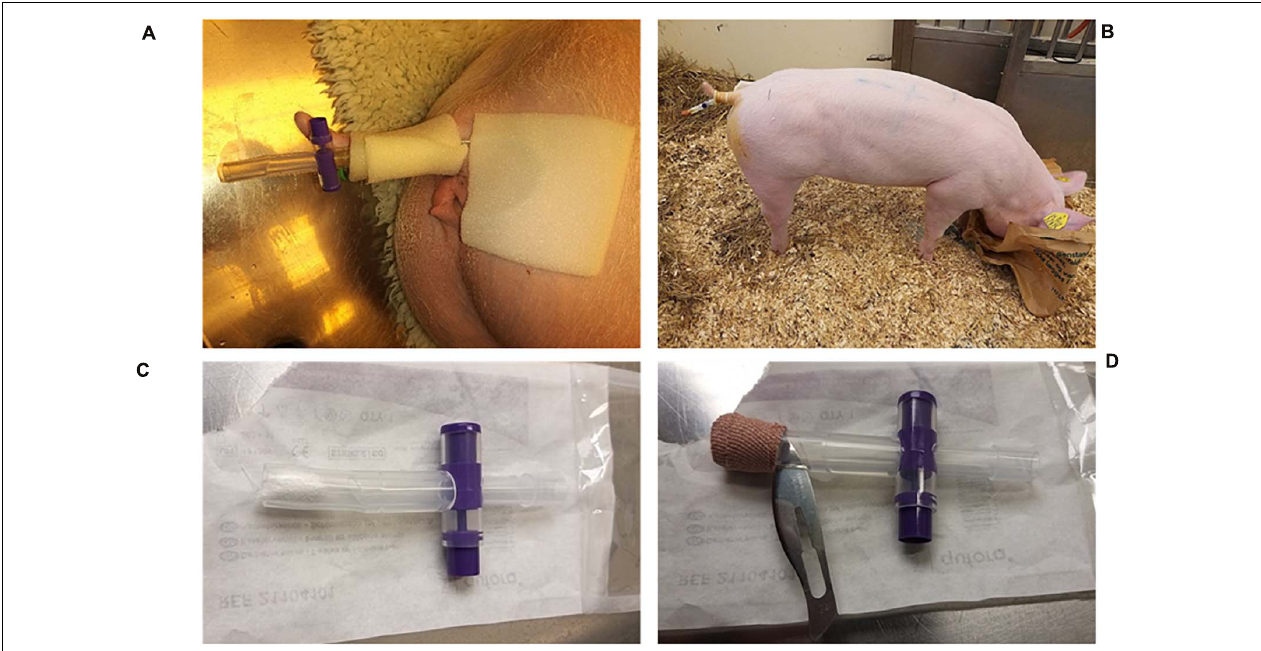
FIGURE 2 | Catheter fixation. (A) External fixation of the catheter. (B) The catheters were easily accessible, and due to proper training prior to the experiment, urine samples could be collected without the need for sedation. (C) To limit contamination of the catheters from the environment, the catheter end was always covered with a replaceable catheter valve that was either closed when accumulating urine for sampling (A) or open and sealed with gauze swaps (C) and secured with tape (D) so that urine could slowly drip through. (D) A secondary non-return valve was made by cutting a thin slit in the silicone right above the gauze. The catheter valve was always discarded before urine sampling and replaced with a sterile valve after